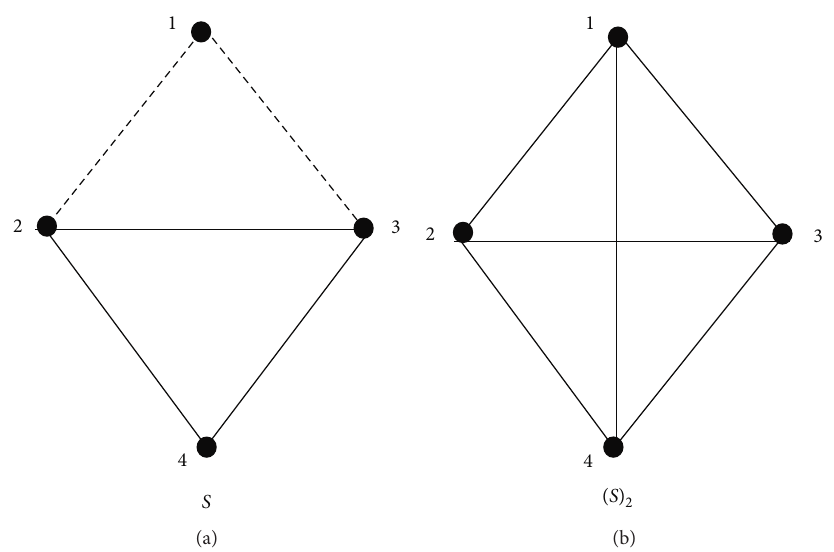
Figure 4: (a) Given signed network Σ . (b) Its 2-path signed